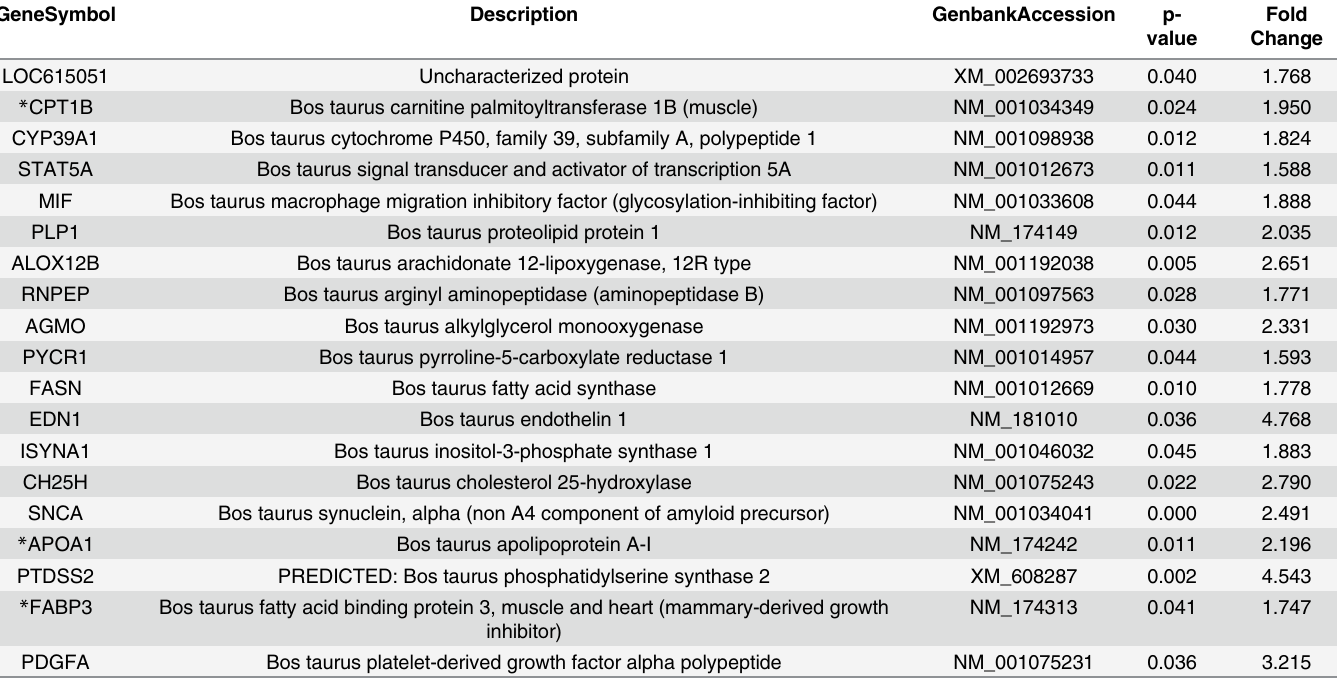
Table 3. The significantly down-regulated lipid metabolism-related genes in fat-1 transgenic